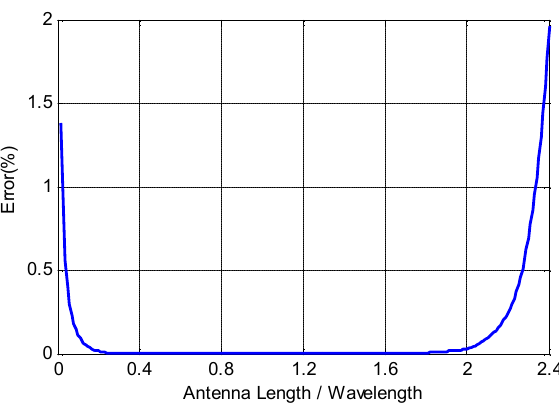
Figure 3: The normalized error for the current distributions. To show the performance of the MBPE technique and MOM, the computation time of MBPE technique and MOM versus number of frequencies is shown in Fig. 4. The computation time of MBPE technique is not significantly increasing when the number of frequencies in the simulation is increased whereas that of MOM is increasing significantly because the MOM simulation is performed for each frequency of interest.